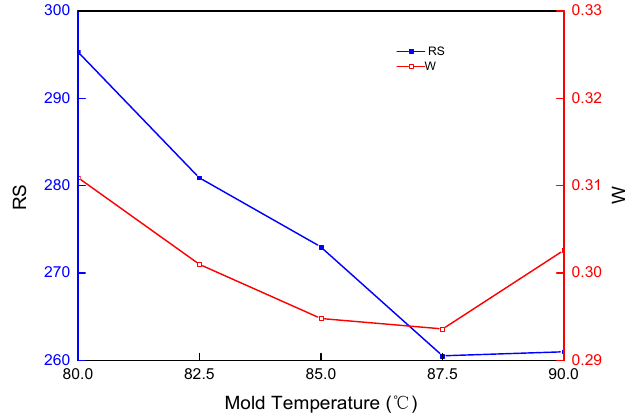
Figure 10. The effect of mold temperature on the residual stress and warpage.